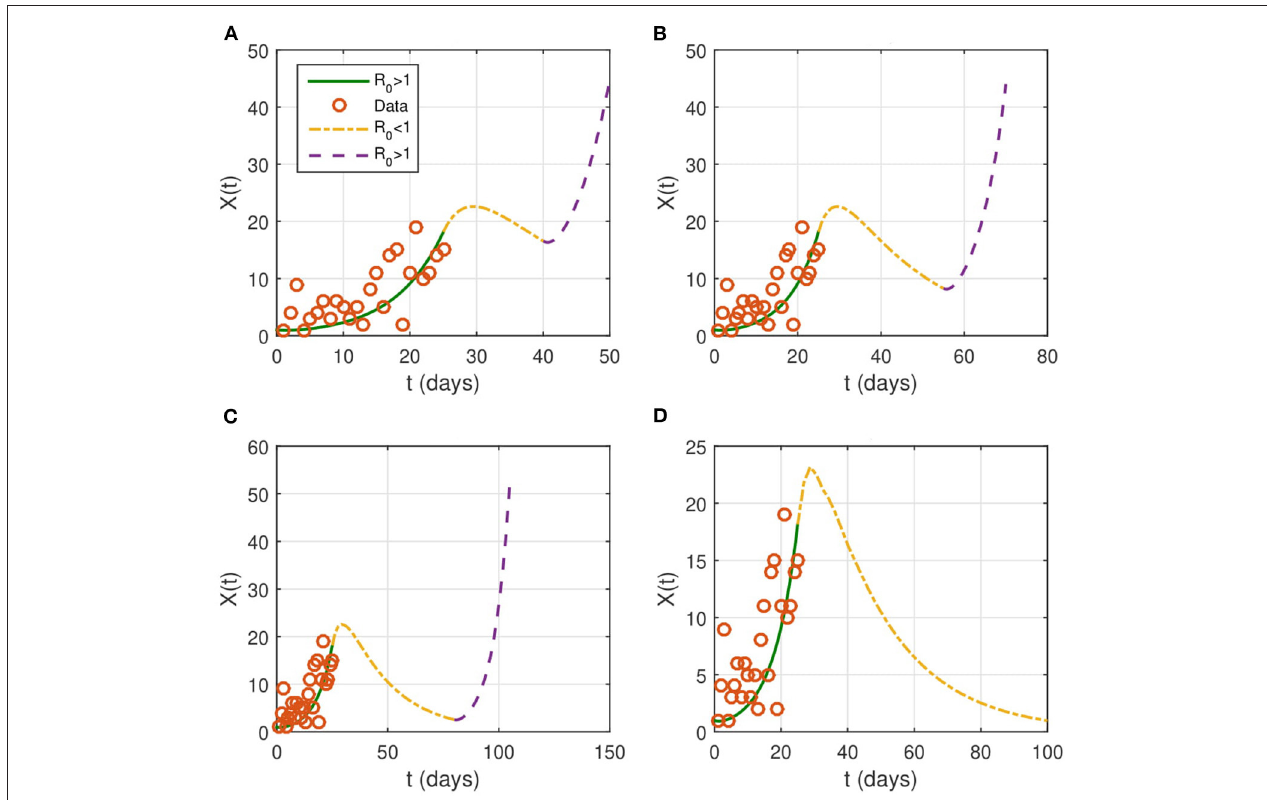
FIGURE 4 | Evolution of the identified infected population of X ( t ). NPIs are considered from April 1 ( t = 26), with β new = 0.1 × β and last for a duration T . We take several intervention’s duration: (A) T = 15 days, (B) T = 30 days, (C) T = 45 days, and (D) T = 75 days. The red circles represent the data for the number of reported